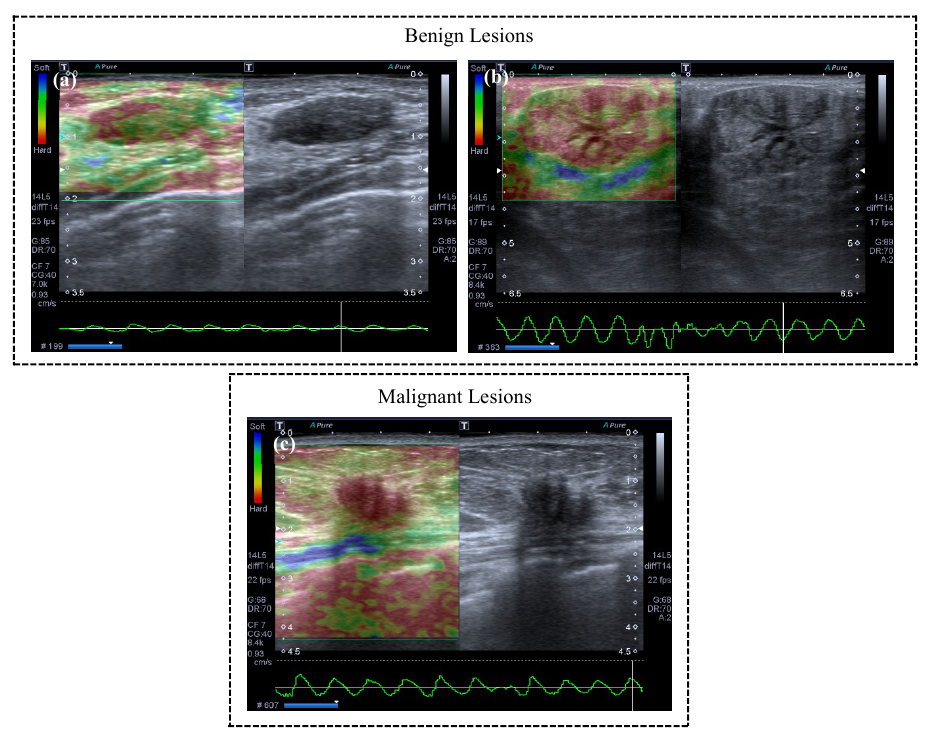
Figure 2. Examples of elastography imaging with different strain. The images were visually classified by a radiologist as follows: ( a ) soft; ( b ) intermediate; and ( c ) hard. The radiologist grouped lesions considered as ( a ) soft and ( b ) intermediate into negative cases (benign) and ( c ) hard lesions were classified as positive cases (malignant).